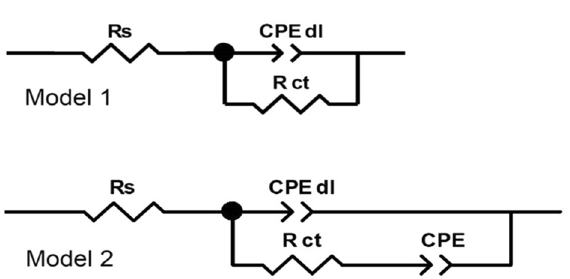
Figure 13. Electric equivalent circuits used for fitting the impedance spectra recorded after 18 h of immersion of Ni–Mo alloy coatings in a 0.05 mol dm −3 NaCl solution.